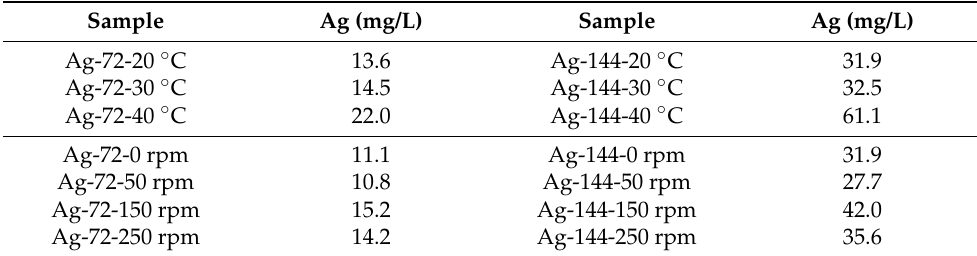
Table 2. Silver concentration of aqueous dispersions of the AgNPs after their isolation determined by ICP.